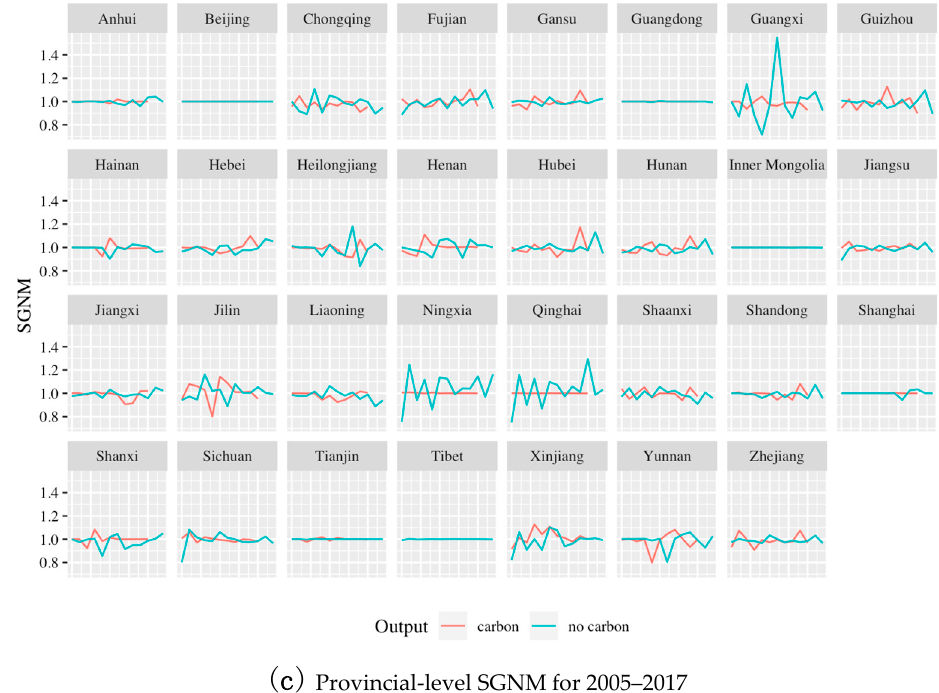
Figure 7. Provincial-level SGN, SGM and SGNM for 2005–2017. SGN, SGM and SGNM are based upon Models (1), (4) and (7). When CO 2 is included as an output (i.e., the curve “no carbon”), the results are available for 2005–2015 and all provinces except Tibet.